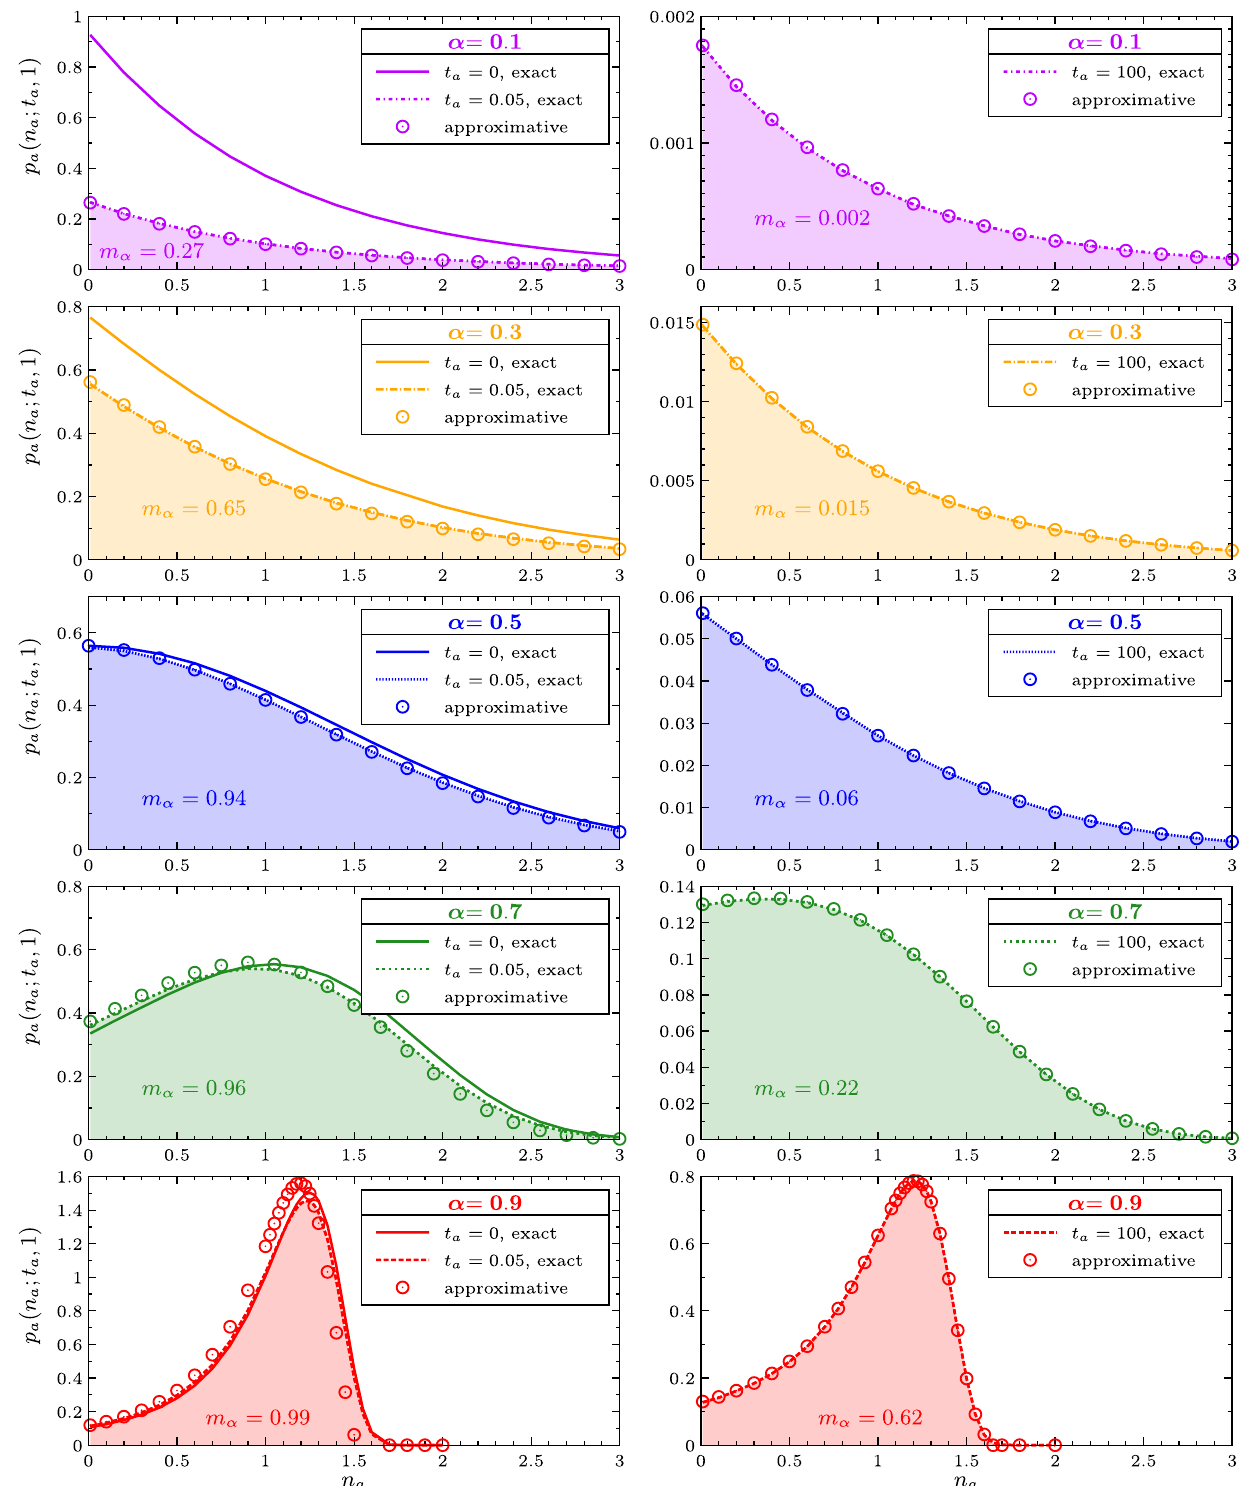
; t ; t Þ of the number of events n FIG. 4 (color online). Continuous part of the PDF p ð n counted during the measurement period a a a ½ t a ; t a þ t (cid:1) . Exact results are provided in terms of a numerical evaluation of the convolution h ð t a ; t Þ (cid:2) t p ð n a ; t Þ as defined through 0 ), the slightly aged Eqs. (7), (11 – 13). We plot sample graphs for t ¼ 1 and various α . Left-hand panels show the nonaged case ( t a ¼ 0 . 05 ), and the leading order approximation for the slightly aged PDF [ t 0 . 05; see Eq (17)]. Right-hand panels show the case ( t a ¼ a ¼ 100 ) and the approximation thereto [ t 100 ; see Eq. (20)]. Note the significantly different vertical scales in the highly aged case ( t a ¼ a ¼ panels, owing to the age-sensitive probability m α to count any events at all during observation (cf. Fig.